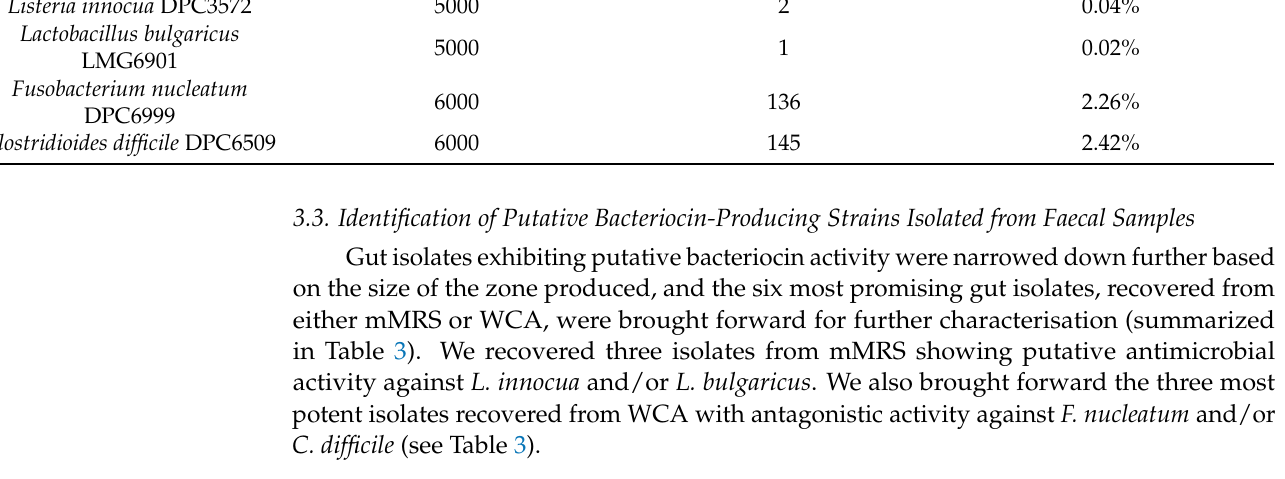
Table 3. Most promising gut isolates showing antagonistic activity against indicators of